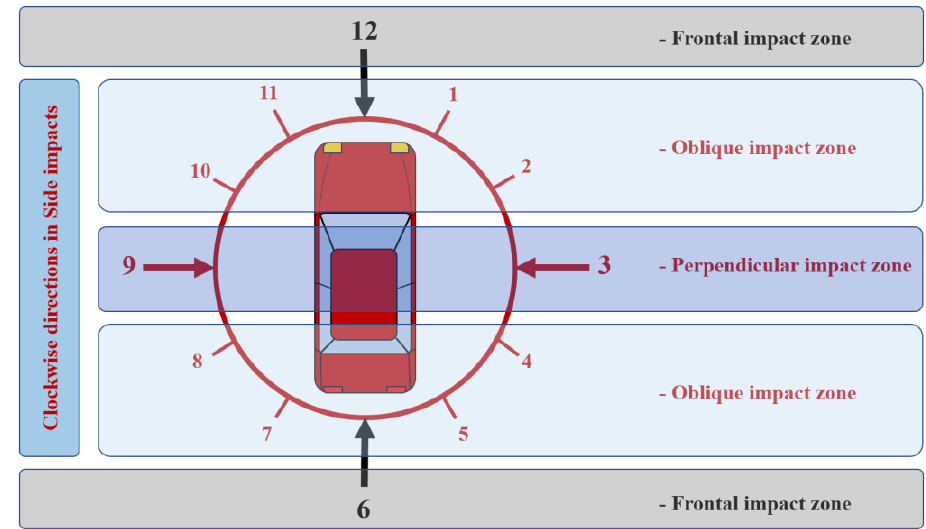
Figure 2. Clockwise directions in side